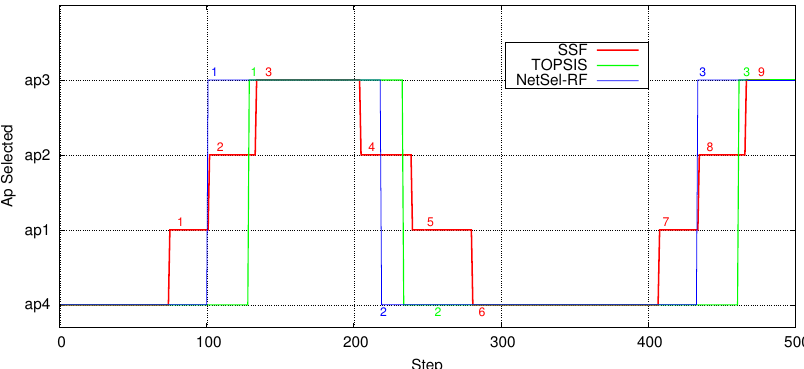
Figure 6. Number of handovers: NetSel-RF with movements